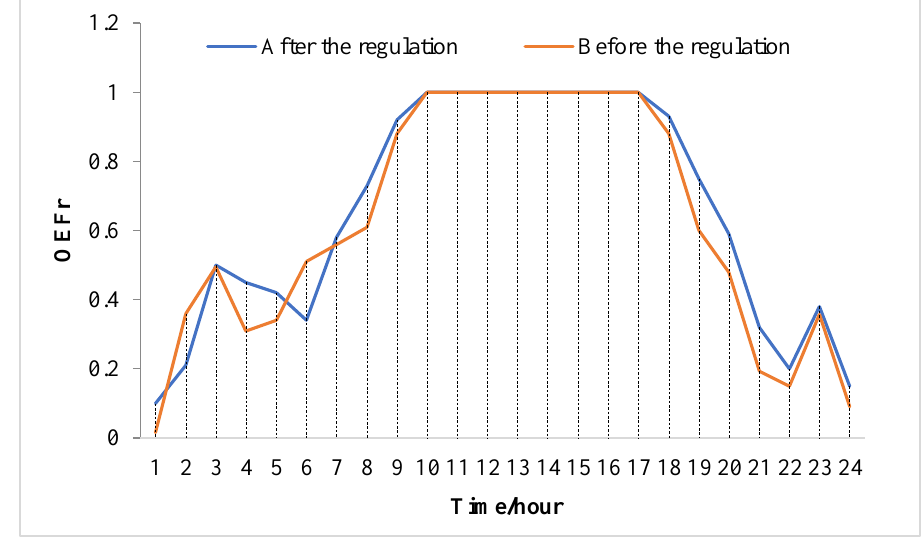
Figure 5. The change in power generation and electricity consumption after VES.